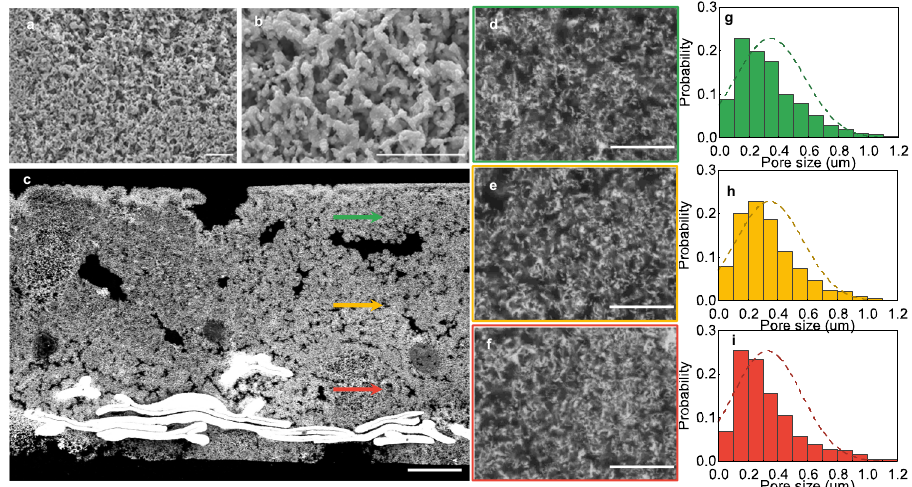
Fig. 2 Morphological characterization of the nanoporous zinc metal electrode. a , b SEM images of the surface of the NP Zn under different magni fi cations. c – f Cross-sectional images of the NP Zn fi lled with the epoxy resin (dark) captured with a back-scattering detector in SEM. The brightest regions at the bottom of c correspond to the Sn-coated Cu substrate. Arrows in c indicate the positions where d – f are captured at a higher magni fi cation, respectively. g – i The pore size distributions in d – f respectively. The scale bars are 10 µ m, except that in c , which is 100 µ phases. When the plate is placed right at the top surface of the Figure 2 shows the product of the transition, a bi-continuous NP initial ZnO compact ( α = 1), we will attain the minimum porosity Zn structure. The surface (Fig. 2a, b), captured by scanning electron of 36.9%. We instead set α to 2 for a porosity of 73.8%, necessary microscopy (SEM), comprises connected, porous structure of an for the later application as a high-DoD anode. average width ~500 nm, as a result of self-organization, most likely